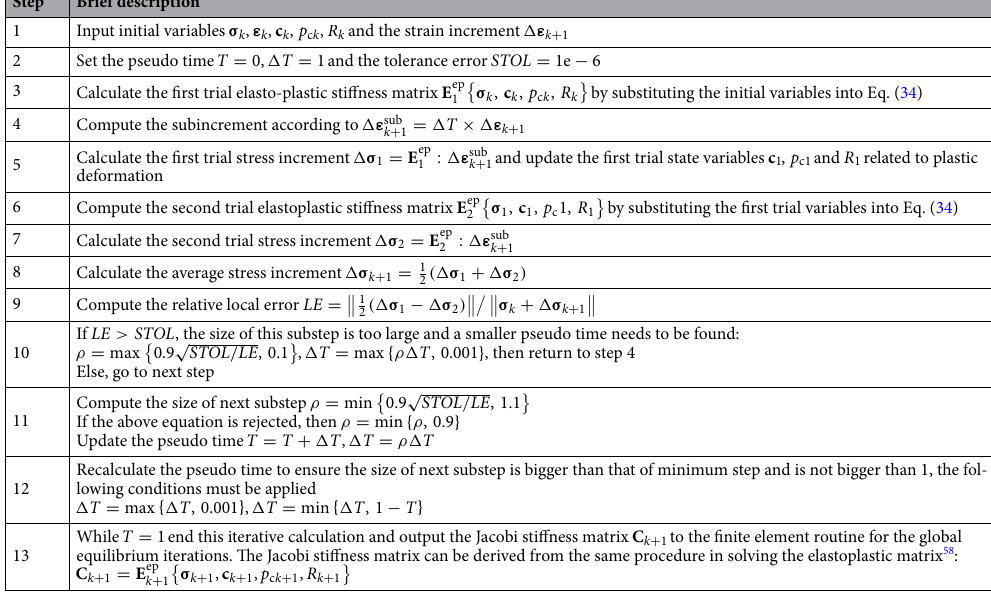
Table 2. Flowchart of the integration scheme.